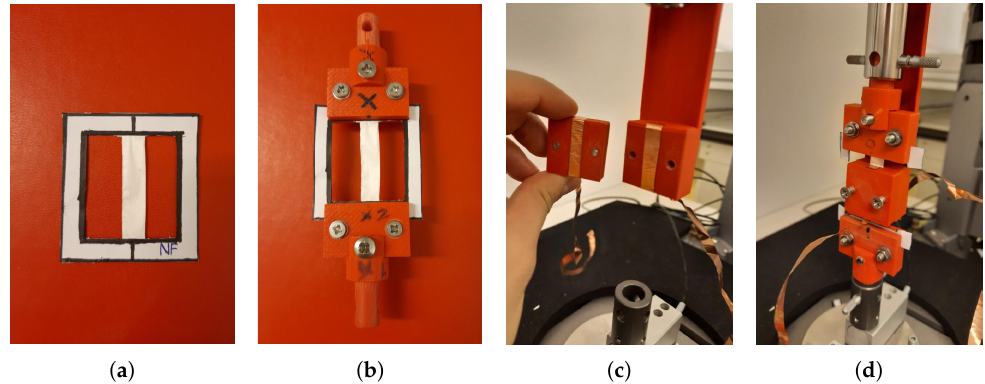
Figure 5. Placement steps of the specimen in the Instron test instrument. ( a ) The specimen anchored into the paper frame. ( b ) The paper frame is clamped. ( c ) The electrodes are glued into the internal groove of the 3D printed electrodes holder. ( d ) The clamped specimen is inserted into the groove of the 3D printed electrodes holder and inside the Instron test instrument. Finally, the paper frame is cut on the sides before the preloading.